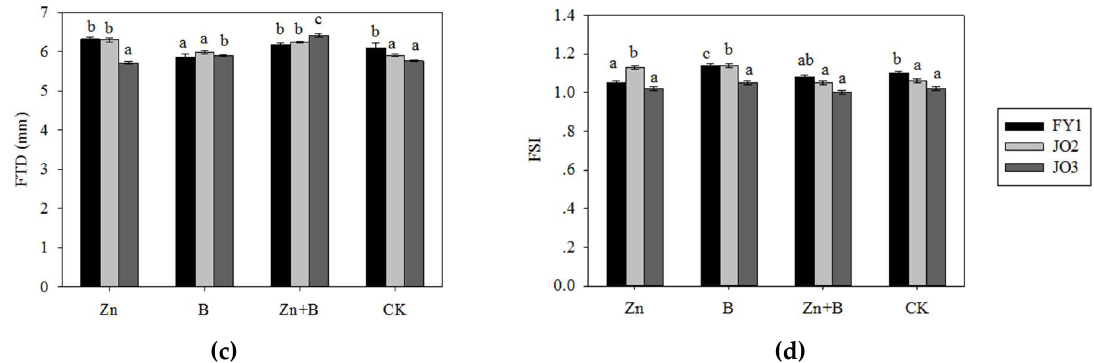
Figure 2. Effects of the foliar applications of the micronutrient solutions on the yield components in L. cubeba . ( a ) HFW: 100-fruit weight; ( b ) FLD: fruit longitudinal diameter; ( c ) FTD: fruit transverse diameter; ( d ) FSI: fruit shape index.